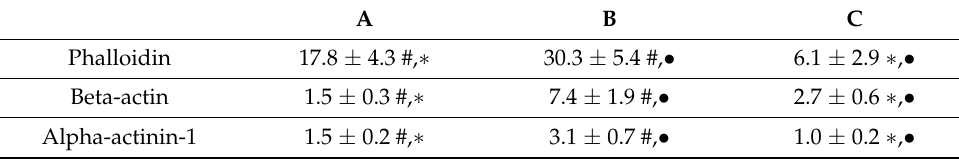
Table 2. Mean fluorescence